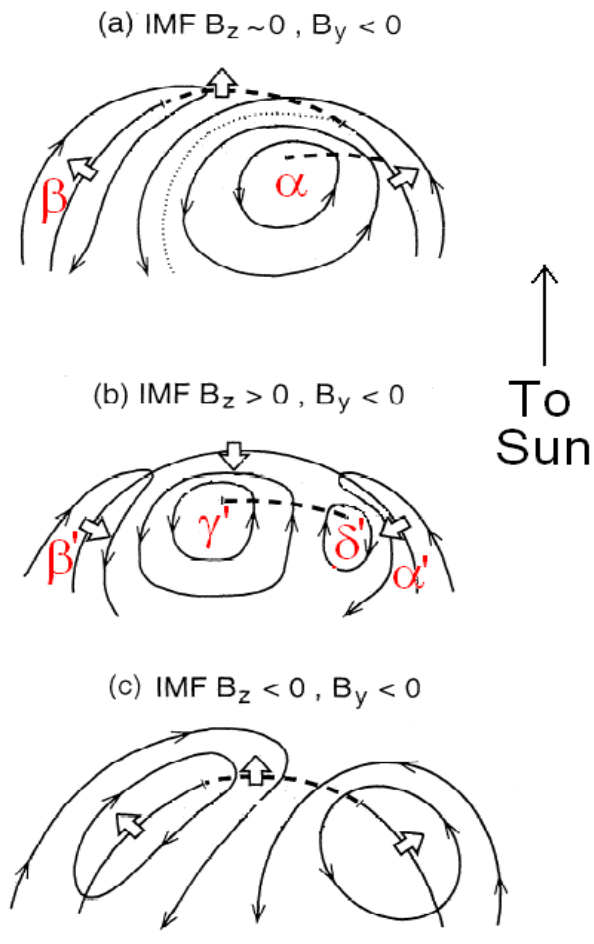
Fig. 7. High-latitude ionospheric convection pattern scheme ex- pected when IMF B y < 0. From top to bottom the cases B z ∼ 0 (a) , B z > 0 (b) , B z < 0 (c) are displayed. Adapted from Sandholt et al.